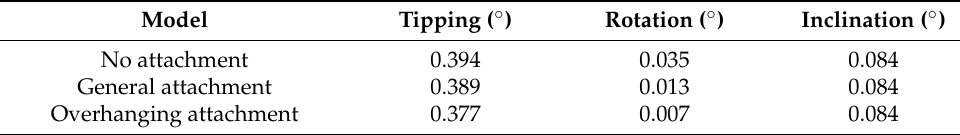
Table 2. Tooth movements measured for 0.5-mm-thick aligner models.